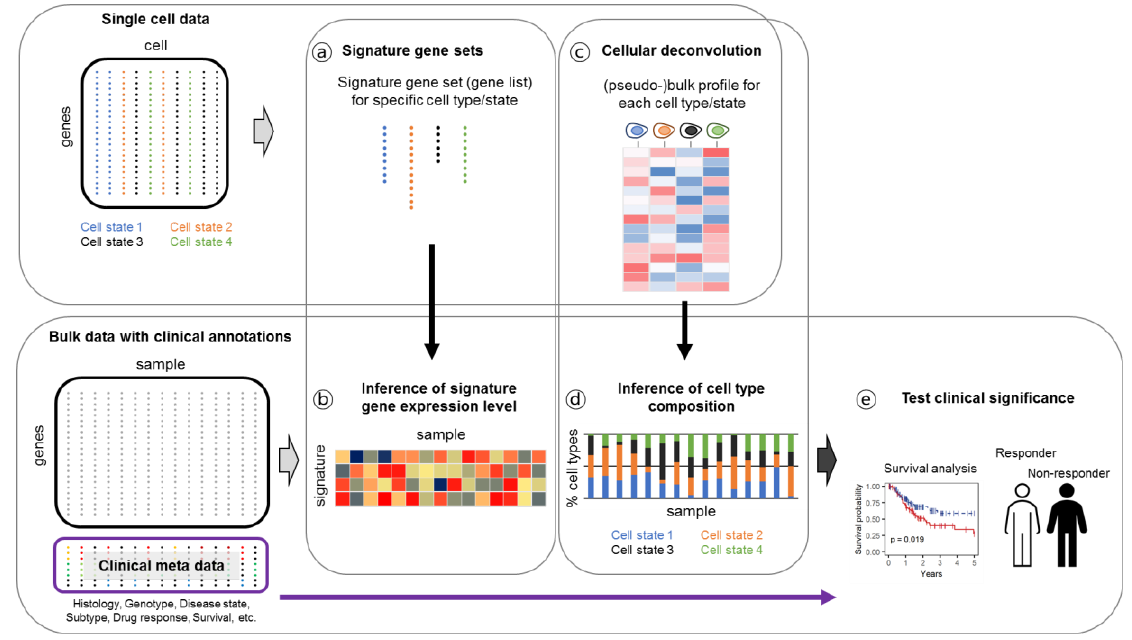
Figure 4. Strategies linking single cell gene expression analysis and bulk-level clinical data.